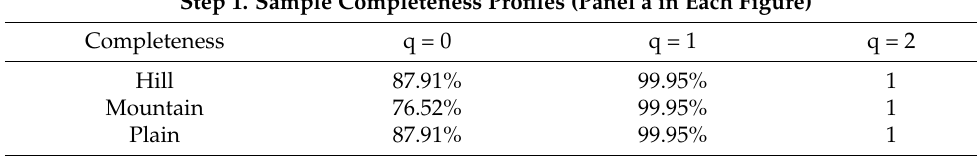
Table 3. The numerical values for the three special cases of q = 0, 1 and 2 for abundance-based soil faunas